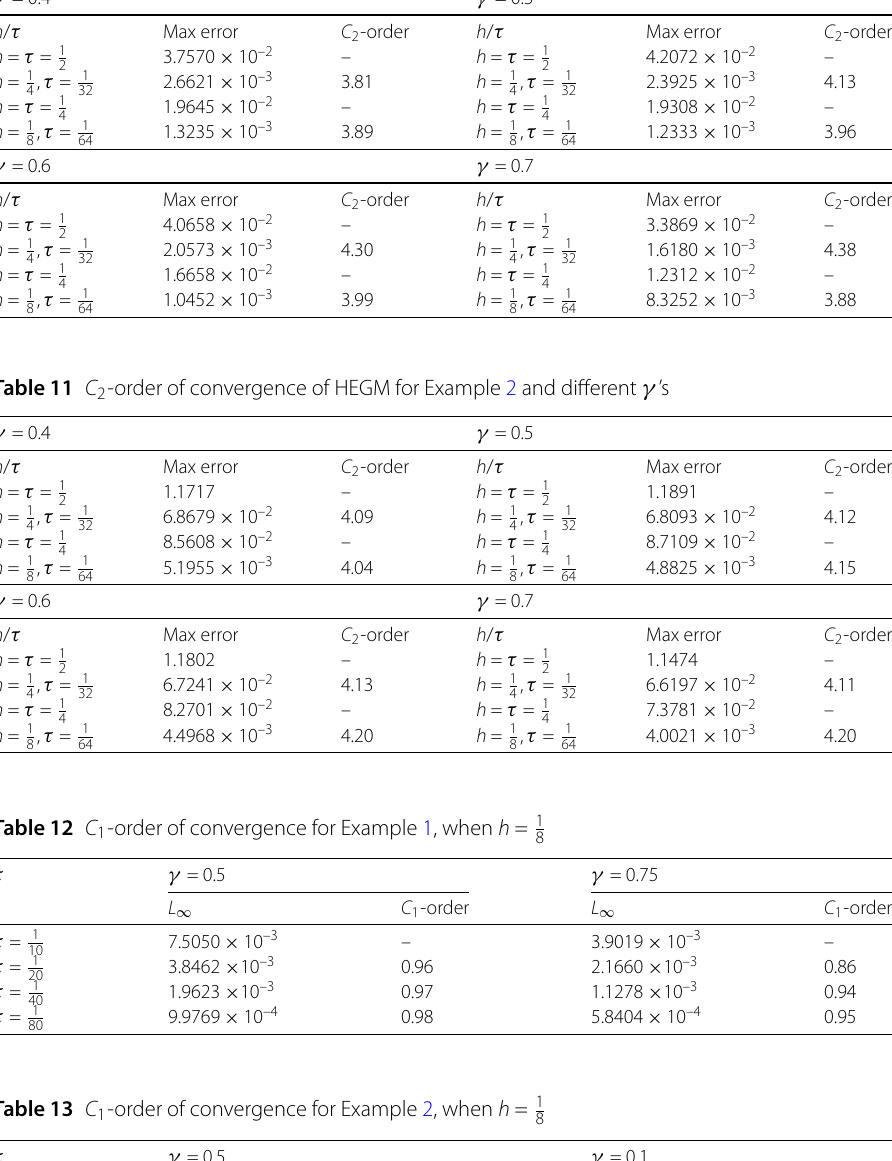
Table 10 C 2 -order of convergence for Example 1 and different γ ’s γ = 0.4